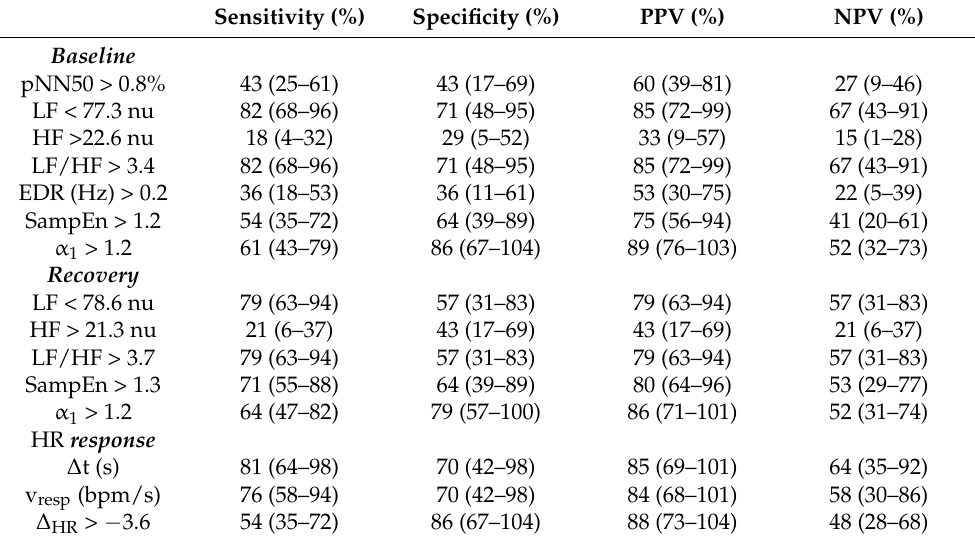
Table 5. Predictive values of HRV indexes in 28 frail and 15 non-frail older